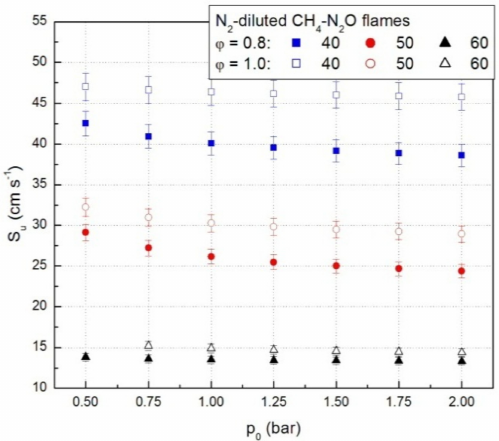
Figure 4. Laminar combustion velocities of lean and stoichiometric CH 4 -N 2 O-N 2 mixtures, from experimental p (t)